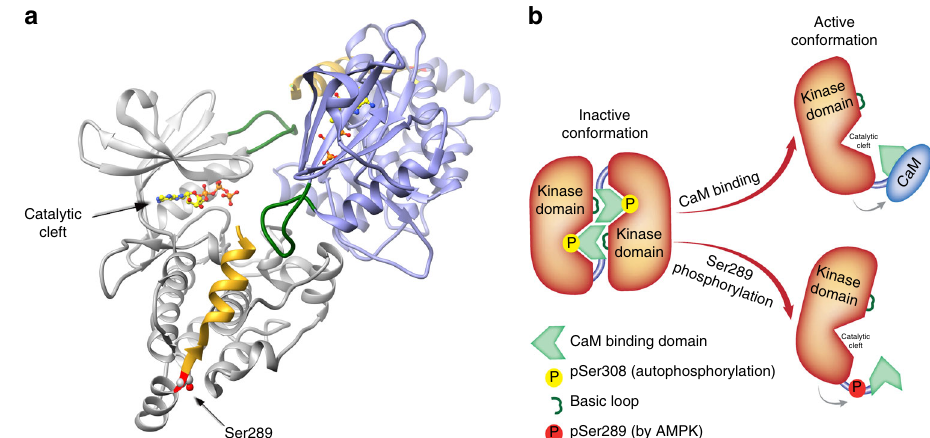
Fig. 9 Ser289 resides in a critical position in the DAPK2 structure. a Ribbon diagram of the DAPK2 dimer (PDB code 2A2A 11 ). The two monomers are shown in gray and purple. The C-terminal part (residues 290 – 304), containing part of the CaM binding helix, is marked in gold, the basic loop (residues 46 – 56) is in dark green and Ser289 is in red (marked with an arrow). An ATP molecule marks the position of the catalytic cleft. b Proposed mechanism of activation by Ser289 phosphorylation. In the inactive state, the CaM binding domain (in light green) blocks the catalytic cleft, Ser308 is autophosphorylated, and DAPK2 is dimeric. Dimerization is mediated in part by interaction of the basic loop (in dark green) with the CaM auto-regulatory domain of the other monomer. CaM binding or Ser289 phosphorylation activate DAPK2 by shifting the CaM binding domain away from the kinase domain, thus exposing the catalytic cleft, reducing Ser308 autophosphorylation and decreasing dimerization. The C-terminal tail of DAPK2 is not represented in this scheme since it is lacking from the available crystal